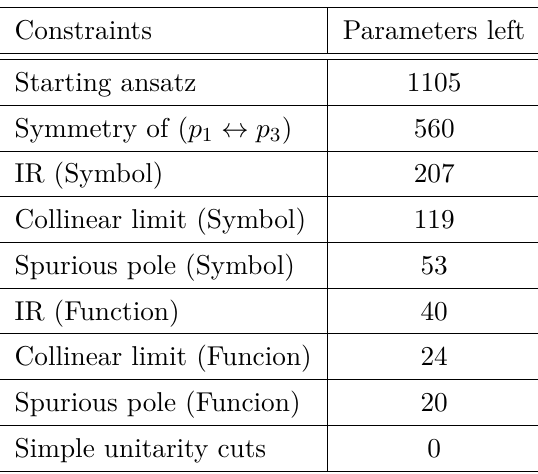
Table 5. Solving for parameters via